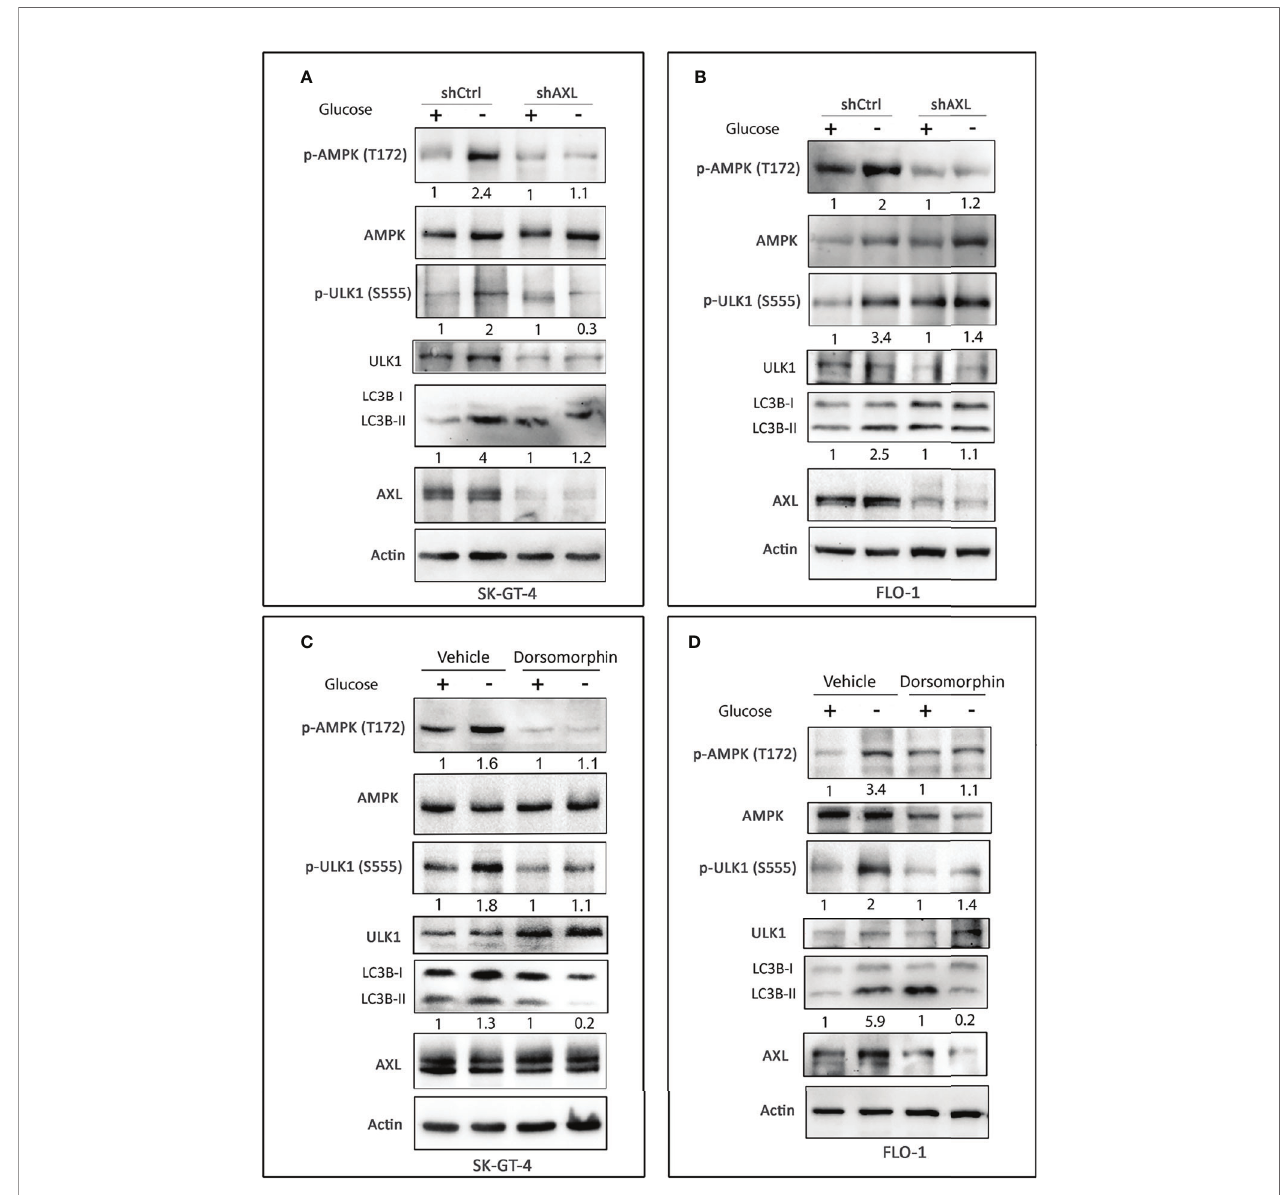
FIGURE 2 | AXL expression and AMPK activation are required for inducing autophagy in EAC cells. Western blot analysis of p-AMPK (T172), AMPK, p-ULK1 (S555), ULK1, LC3B, and AXL proteins in whole cell lysates from SK-GT-4-shCtrl and SK-GT-4-shAXL cells (A) and FLO-1-shCtrl and FLO-1-shAXL cells (B) cultured in complete medium with and without glucose for 4 h to induce autophagy. Western blot analysis of p-AMPK (T172), AMPK, p-ULK1 (S555), ULK1, LC3B, and AXL in cell lysates from SK-GT-4 (C) and FLO-1 (D) cells following treatment with vehicle or AMPK inhibitor dorsomorphin (5 µM) in the presence or absence of glucose for 4 h. Gel loading was normalized for equal b